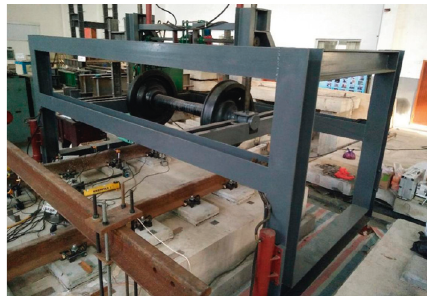
Figure 5: Wheelset drop impact test